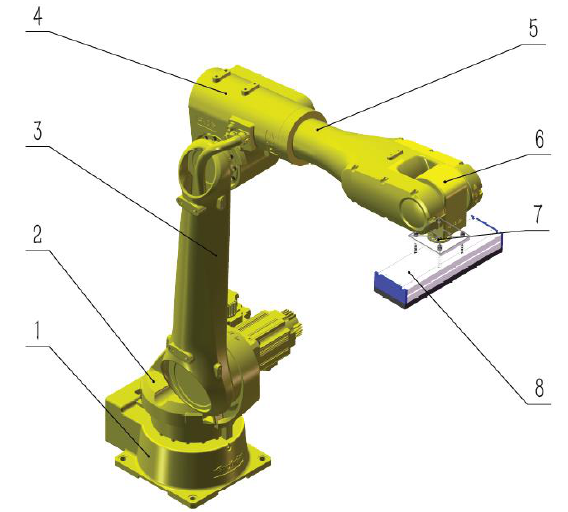
Figure 1. Schematic diagram of palletizing robot. 1. Base; 2. waist link rod; 3. large arm link rod; 4. elbow link rod; 5. small arm link rod; 6. wrist link rod; 7. rotary flange; 8. end actuator.